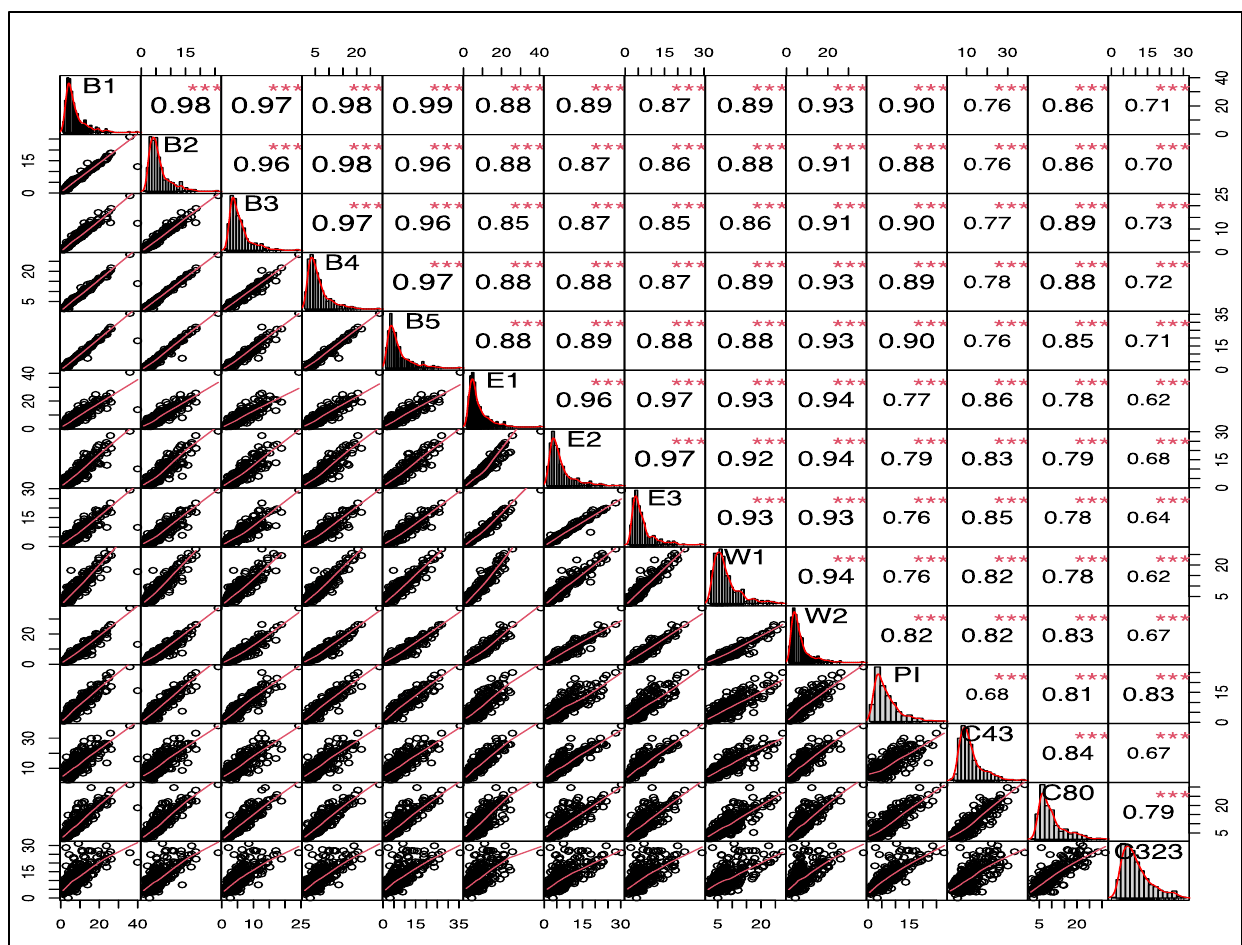
Figure 6. The Spearman’s Rho correlations plot also show the density functions, histograms, and smoothed regression analysis. Histogram curves and regression analyses corroborate the similarity in temporal relationships between all the sampled and TCEQ CAMS sites.